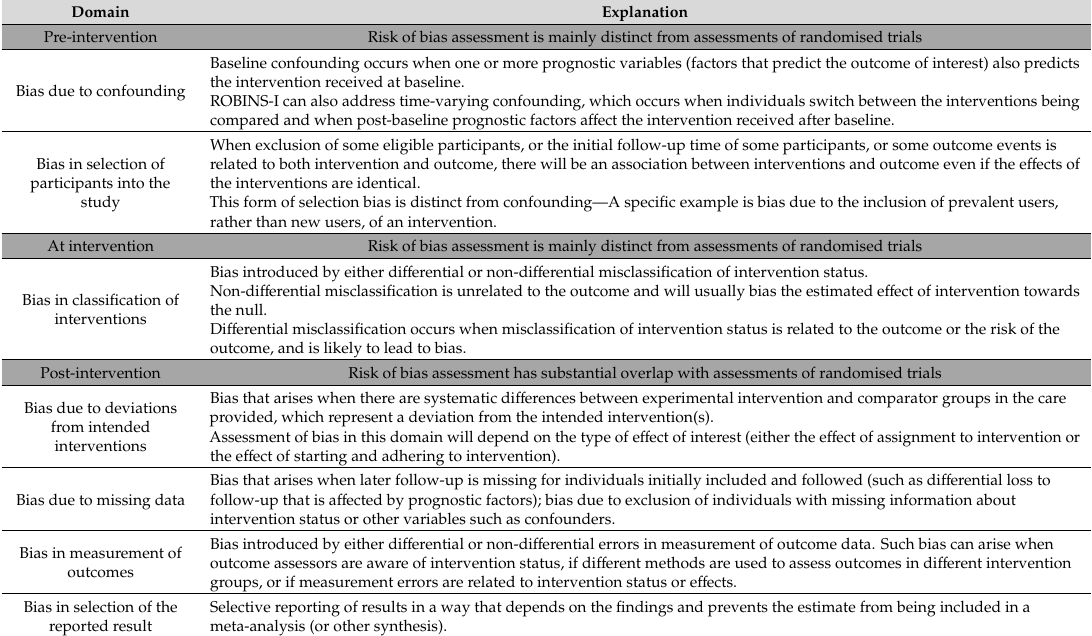
Table A3. Robins-I tool for assessing risk of bias for non-randomised studies [15].